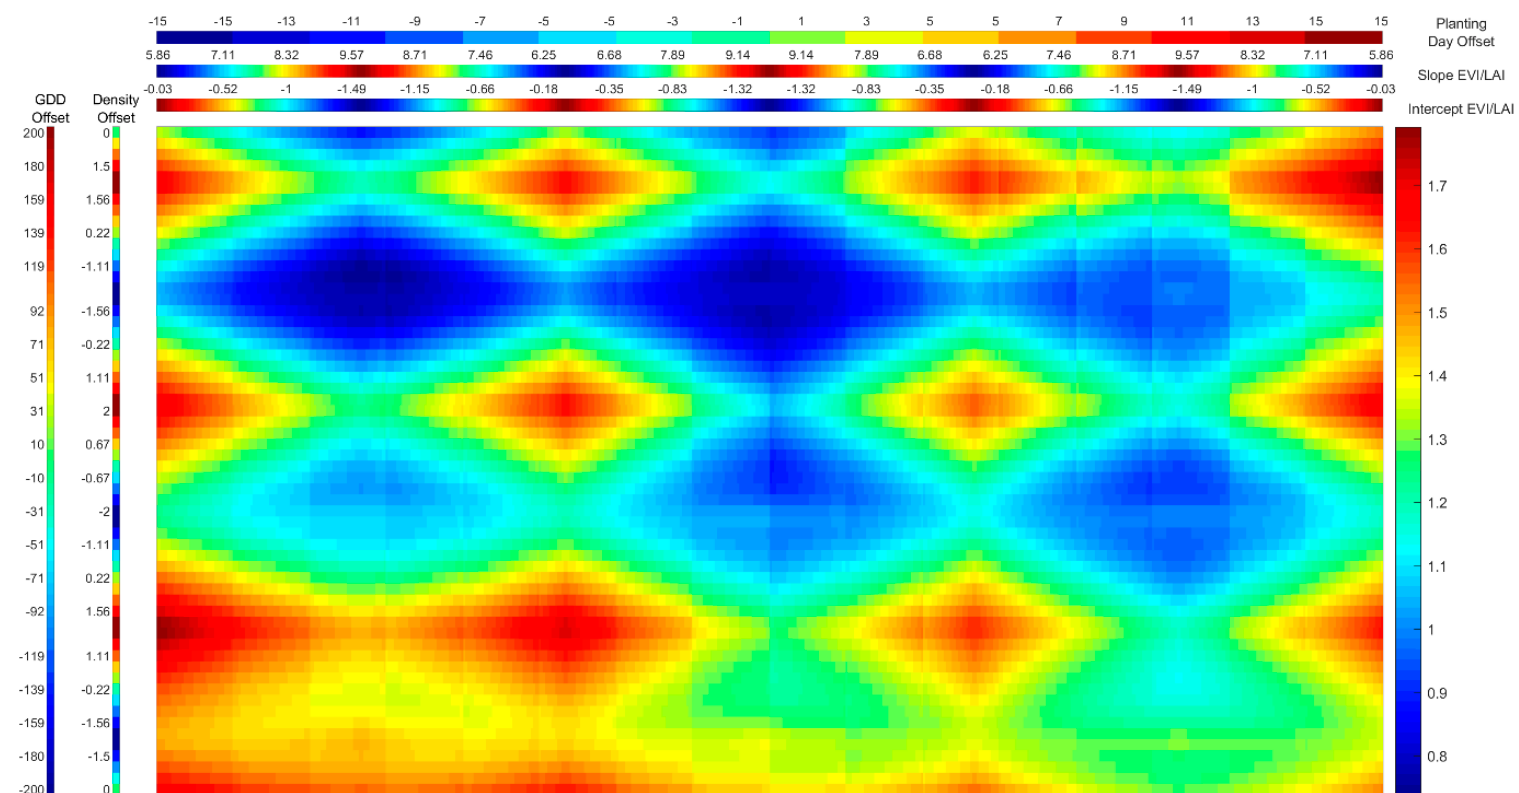
Figure 5. RMSE of modeled LAI with respect to MODIS-retrieved LAI while varying planting date, seed GDD to maturity, and planting density, and MODIS EVI2/LAI regression coefficients. Leftmost column represents offset from actual seed GDD to maturity in °C in simulation variant, while second leftmost column represents offset from actual planting density in plants/m 2 in simulation variant. Topmost header represents offset from actual planting day in days in simulation variant. Second topmost header represents slope of EVI2/LAI regression coefficients. Third topmost header represents intercept of EVI2/LAI regression coefficients. Color bar at right and color in main panel represents LAI RMSE for each simulation variant determined by column and header. N =3280.